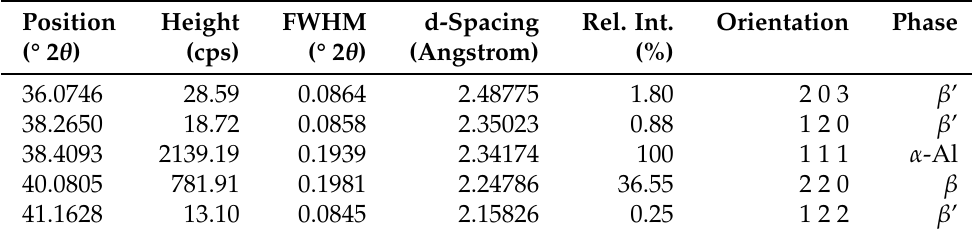
Table 5. Summary of the Rietveld refinement of microdiffraction spectrum in the HAZ of the sample M2 (as-received alloy).